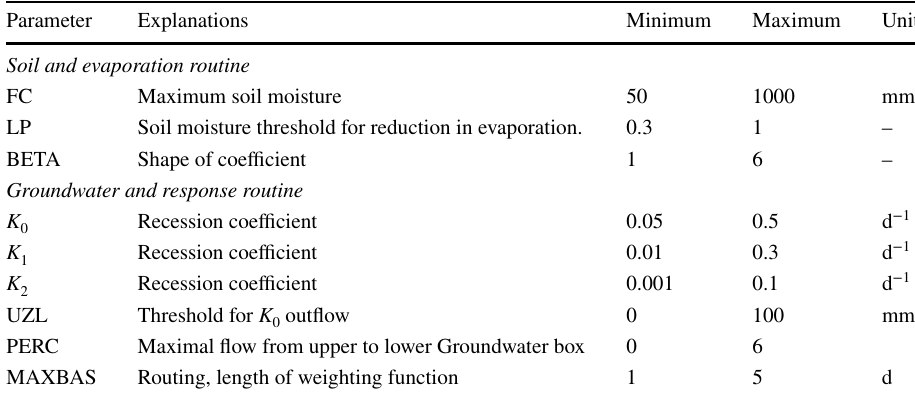
Table 2 Calibrated HBV parameters and their